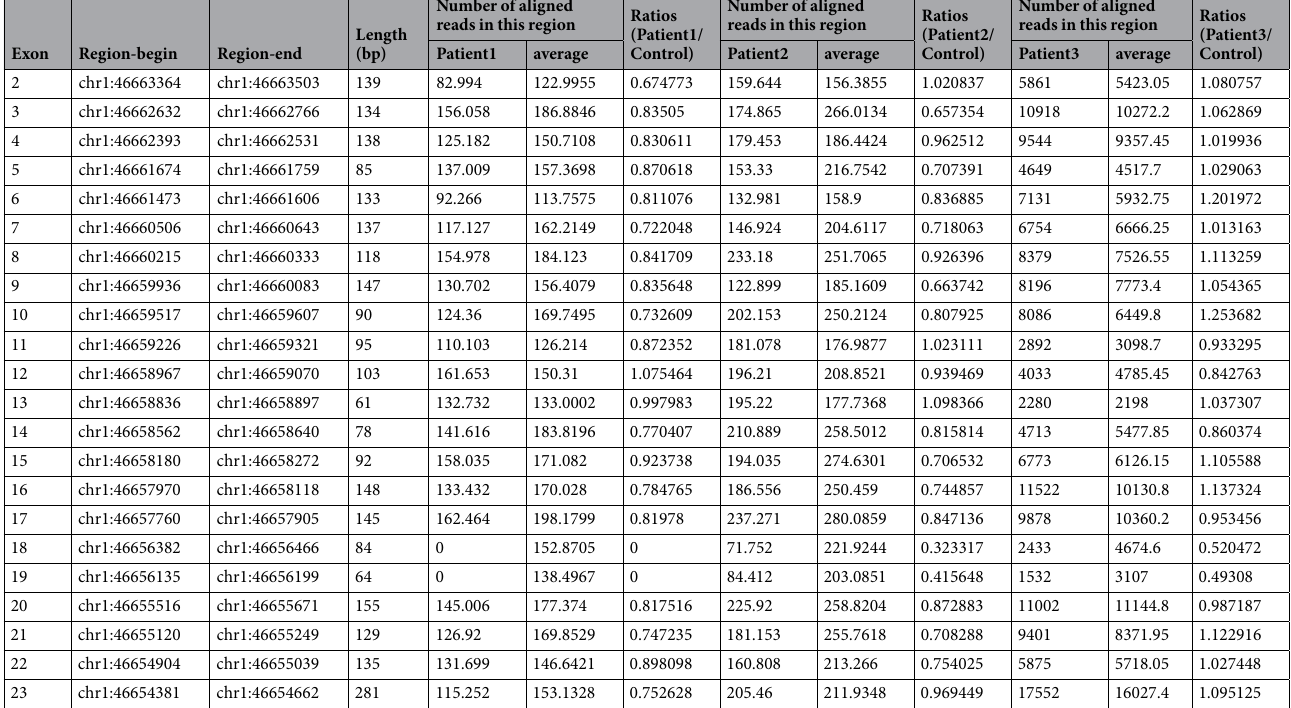
Table 1. Summary of the number of each exon sequence reads from patient, the average number of each exon sequence reads from the 20 control samples, and patient/control